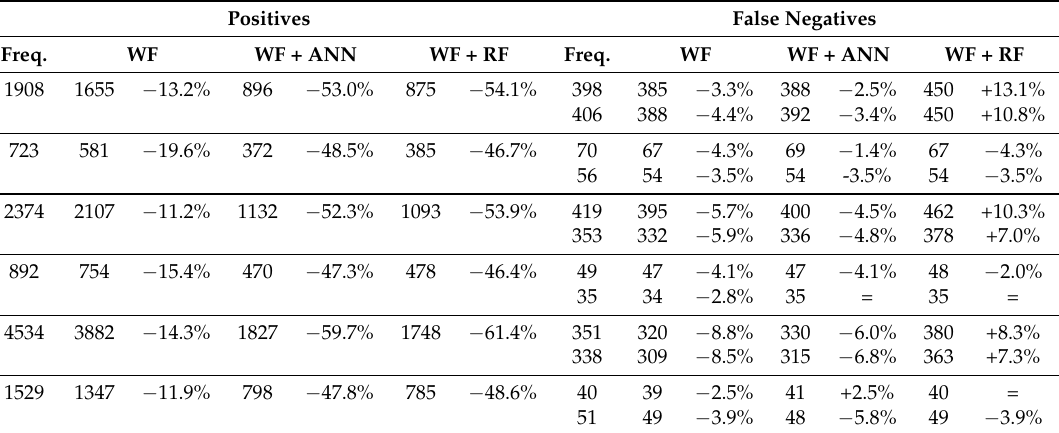
Table 6. Accuracy of error classification using frequency filter, weighted frequency (WF) filter, and their combination with artificial neural networks (ANN) and random forests (RF). Positives False Negatives Freq.